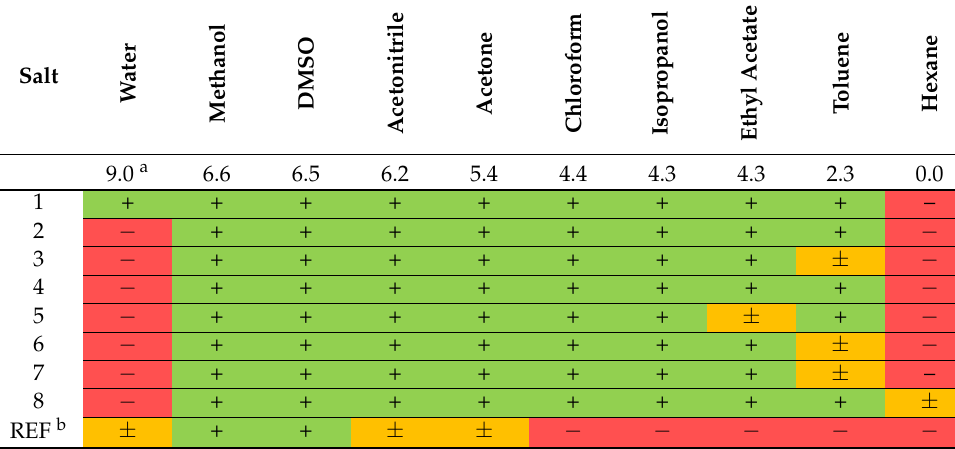
Table 2. Solubility of the prepared ILs ( 1 – 8 ) at 25 ◦ C.